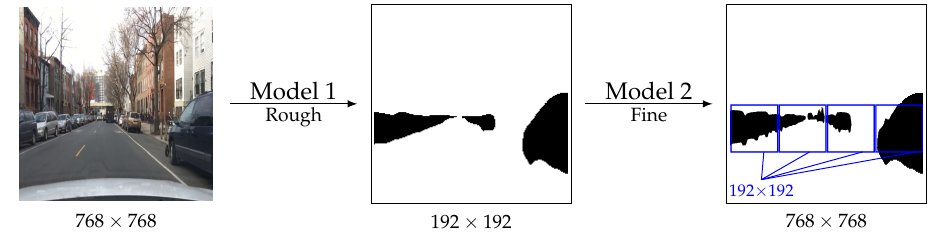
Figure 1. Illustration of the proposal (BDD dataset).